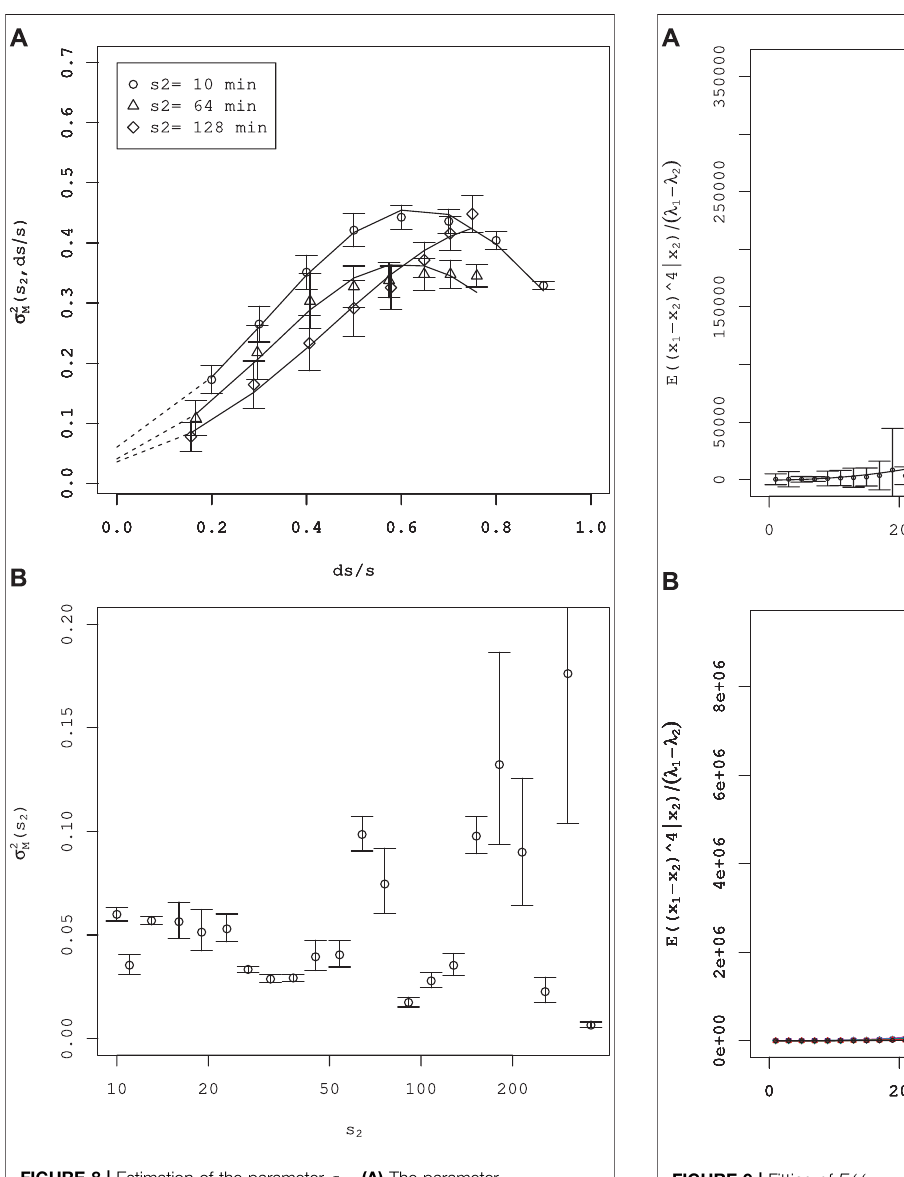
FIGURE 9 | Fitting of E (( x 1 − x 2 ) 4 function. (A) Standarderrorsaredenotedbytheerrorbar. (B) Fittingisapplied to various s 1 and s 2 combinations.